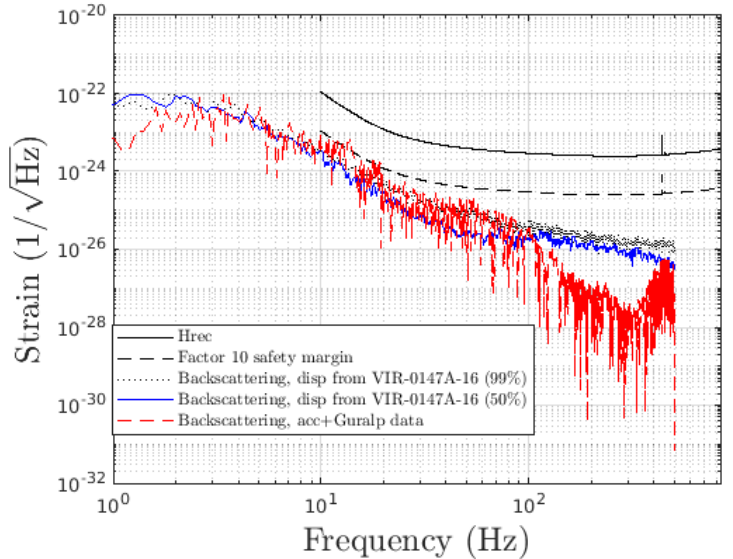
Figure 18. Noise projection of the displacement of the cryobaffle close to the EM. The black solid curve is the sensitivity curve expected for O5. The black dashed curve is the factor ten–safety margin curve. In solid blue is the projection of the cryobaffle displacement from Section 5.2, and the black dotted curve represents the most conservative projection (corresponding to a 99 percentile–displacement curve). In dashed red, the projection of the cryobaffle displacement obtained in Section 5.1 can be seen. In all cases, the projection is below the factor ten safety